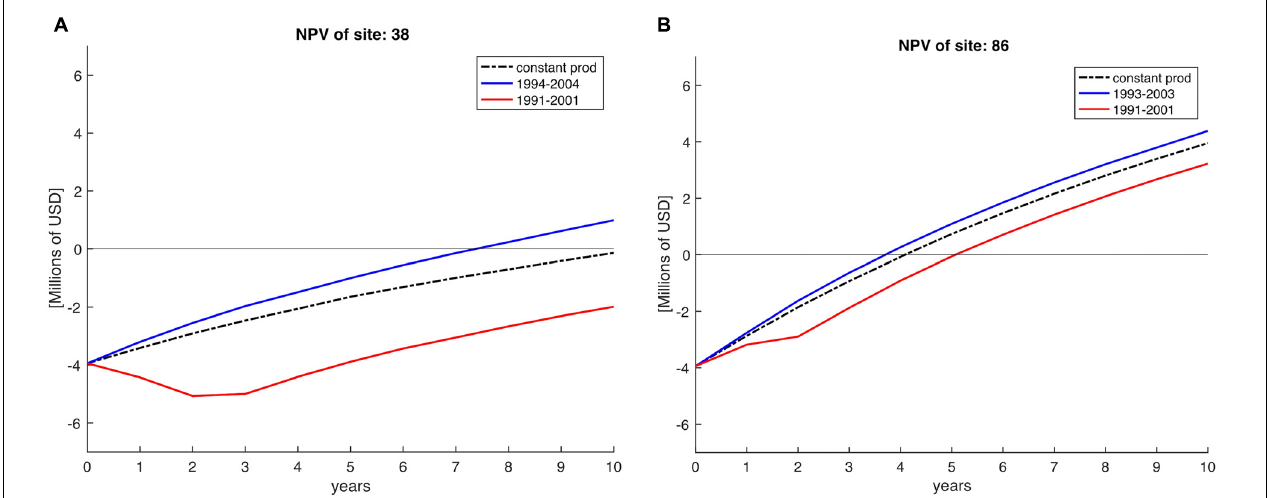
FIGURE 5 | Net Present Value (NPV) calculations on a 10-year horizon, indicating Net Present Value for sites 38 (A) and 86 (B) , both located in the Northern region of the SCB. NPV profile if calculated constant (averaged) across the 28 years of simulation is represented by the dashed black line. The red line indicates the NPV profile obtained for period 1991–2001 indicating less profits than a posterior NPV profile (blue line) calculated for periods after. Horizontal line indicates the time when the investments are recovered at the time at intersection with NPV lines.